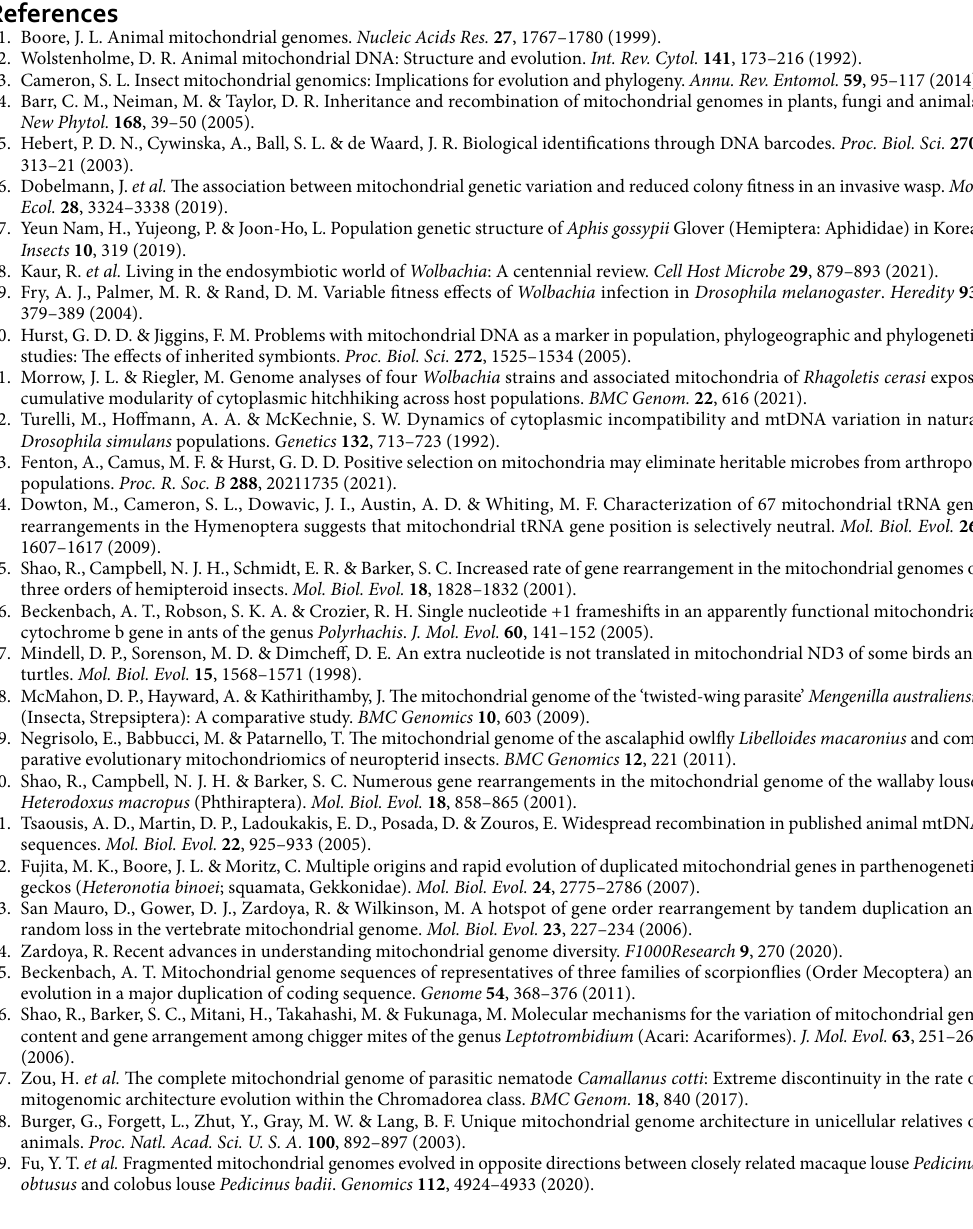
D. daci mitogenome filtered from the WGS library of B. frauenfeldi 485 was deposited under accession num- ber MW233588. Fruit fly mitogenomes from this study were deposited under accession numbers